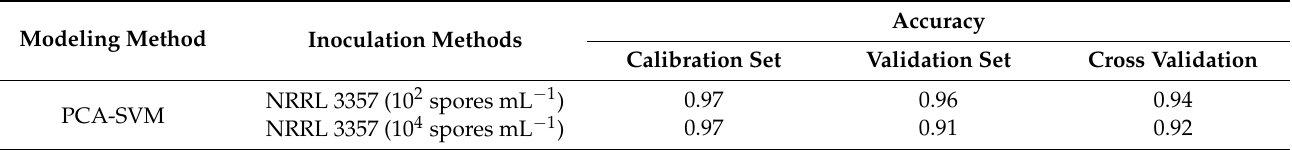
Table 1. Classification results of the A. flavus growth period based on the full